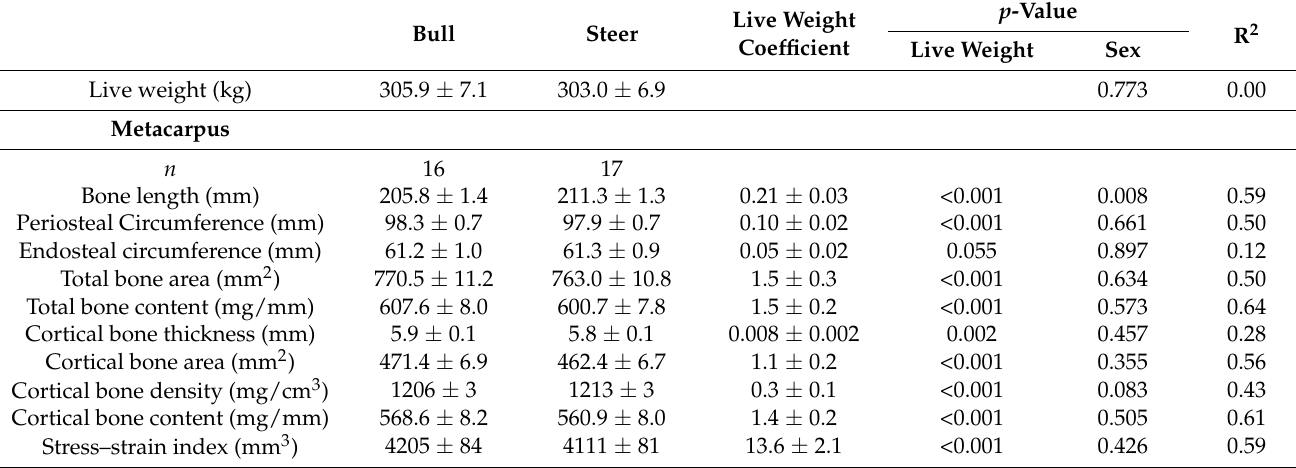
Table 1. Least squared means and standard error for bone parameters in the metacarpus and humerus with the effect of sex in bulls and steers at 11 months of age from cohort one where there was no interaction of weight and sex. p -Value Live Weight Bull Steer R 2 Coefficient Live Weight Sex Live weight (kg) 305.9 ±